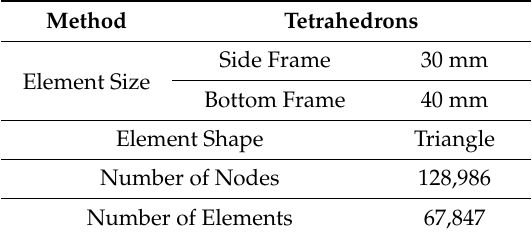
Figure 18. Mesh for thermal elasto-plastic analysis. Table 10. Mesh properties for thermal elasto-plastic analysis.